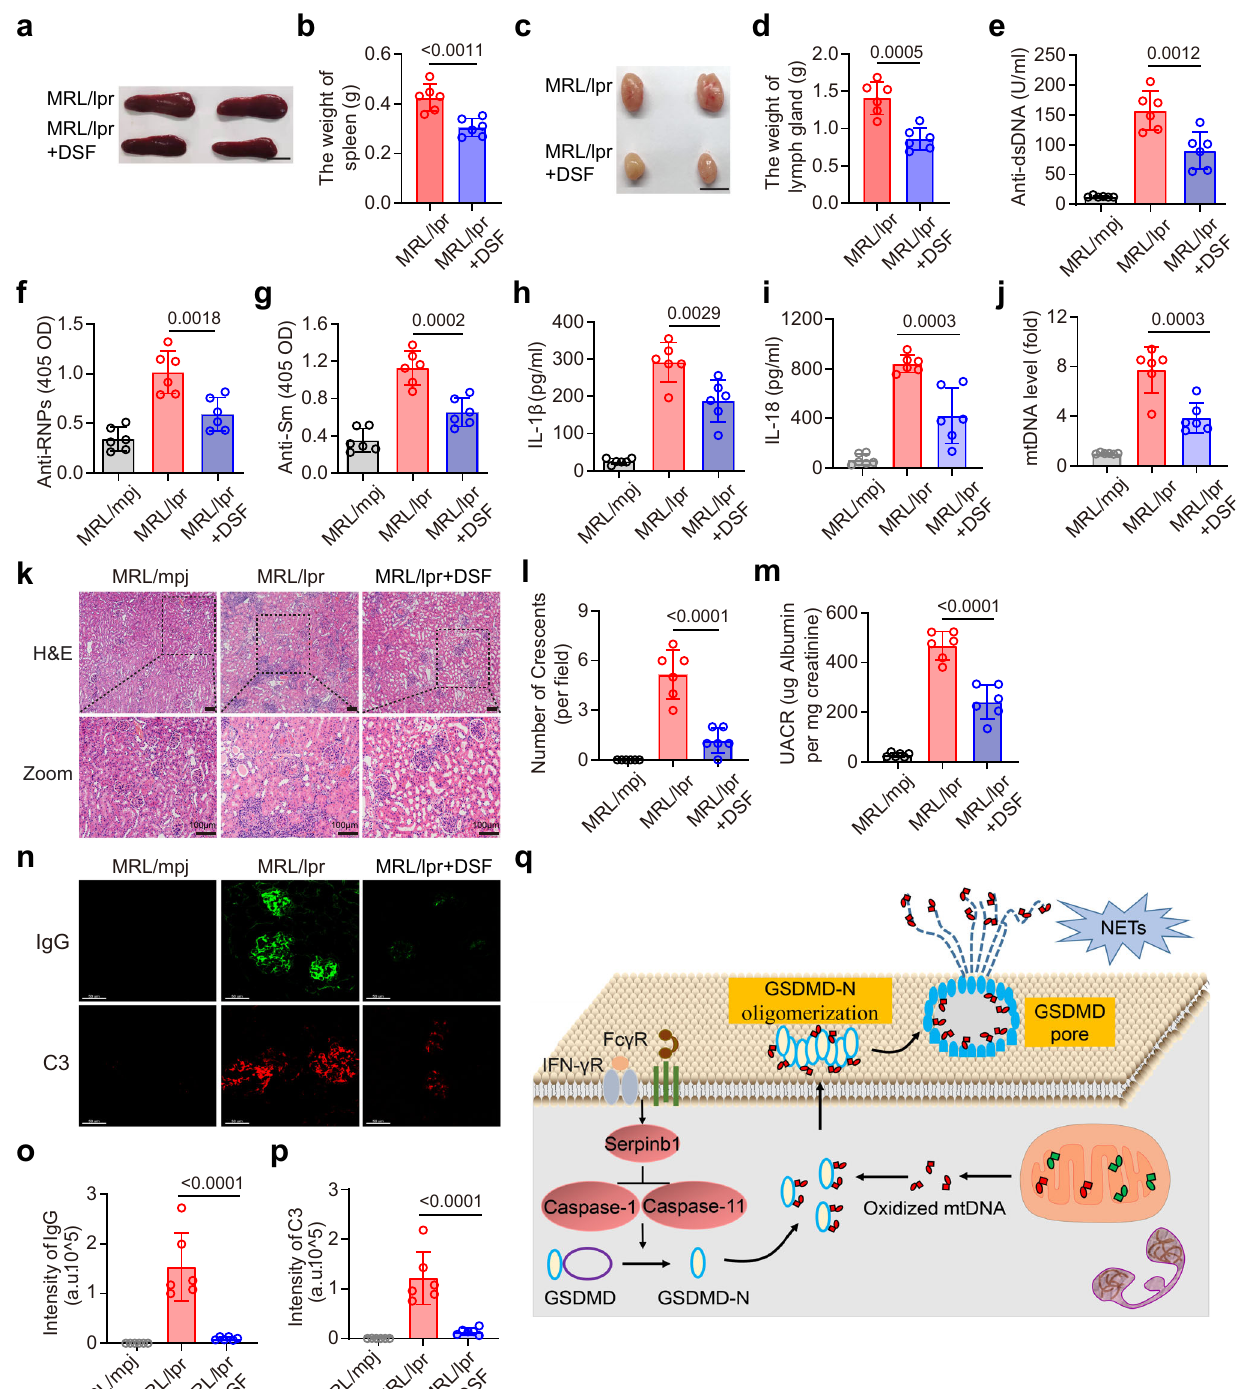
Fig. 9 | GSDMD inhibition alleviates disease activity in MRL/lpr mice. a Images of spleen from MRL/lpr mice or MRL/lpr with DSF treatment. Scale bar, 1cm. b Quantitative analysis of spleen weight. c Images of lymph gland from MRL/lpr mice or MRL/lpr with DSF treatment. Scale bar, 1cm. d Quantitative analysis ofthe weight of lymph gland (4 lymph glands).ELISA analysisof the levelsof anti-dsDNA ( e ), anti-RNPs ( f ), anti-Sm ( g ), IL-1 β ( h ) and IL-18 ( i ) in serum samples from the indicatedgroups. j qPCRanalysisof D-loopinserumfromindicatedgroups. k H&E stainingofkidneysectionfromindicatedgroups;scalebar=100 μ m. l Quantitative analysis of numbers of glomerular crescents from indicated groups. m ELISA of urine albumin-to-creatine ratio in MRL/mpj, MRL/lpr, and MRL/lpr mice treated withDSF. n Renalsectionfromtheindicatedtreatmentgroupswerestainedwithor